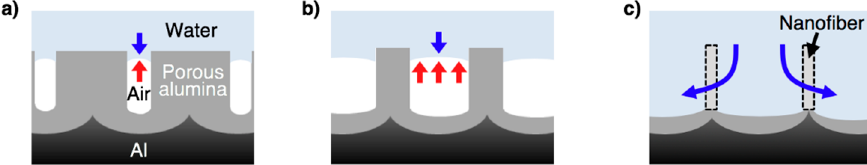
Figure 9. Schematic illustrations of the cross-section of the anodized specimen after the water droplet was placed on the surface: ( a ) porous alumina with narrow pores, ( b ) porous alumina with large-scale pores, and ( c ) nanofiber-covered